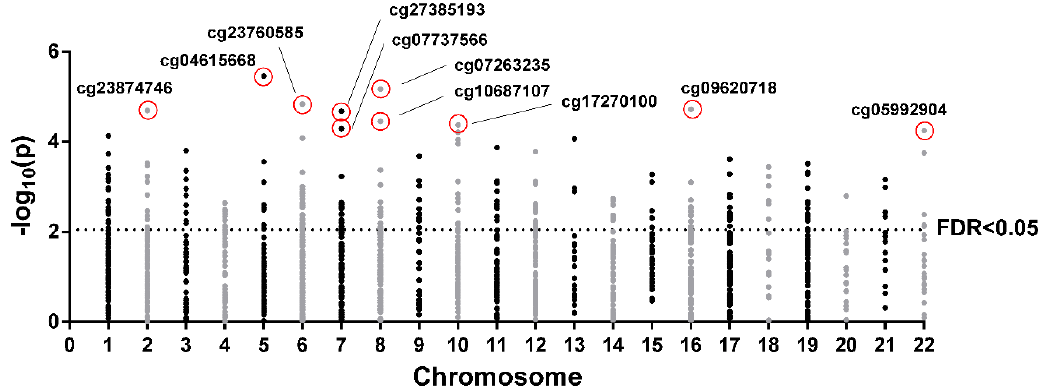
Figure 3. Manhattan plot of 1416 CpGs selected by slope >|0.005| in each chromosome. Points above the horizontal line are false discovery rate (FDR) < 0.05. The top 10 CpGs are indicated.